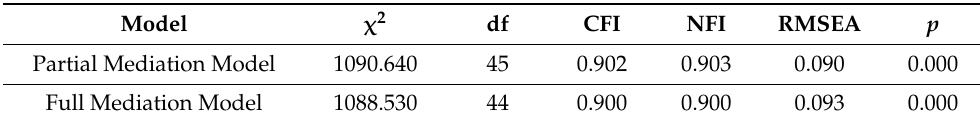
Table 4. Goodness-of-fit Indexes for the Structural Equation